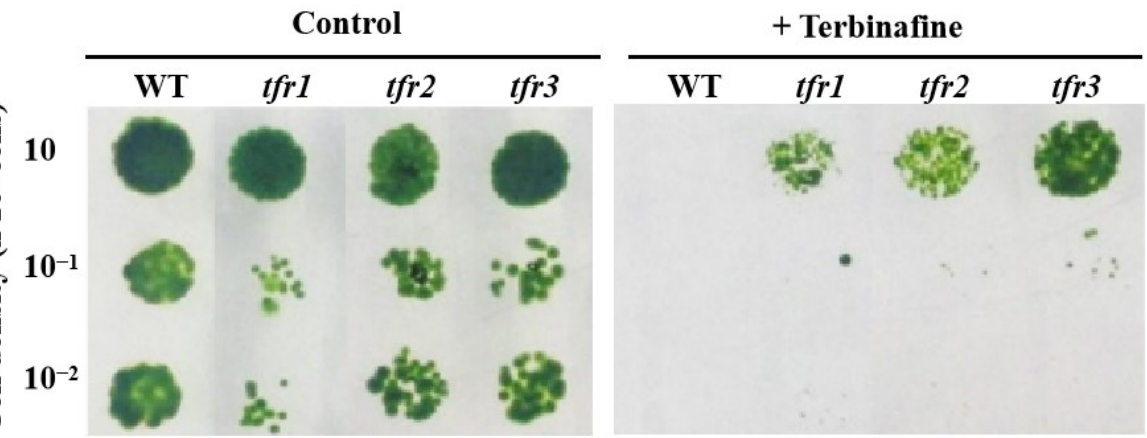
Figure 2. Growth phenotype of wild type (WT) and tfr mutants of C. reinhardtii . Serial dilutions of cells were spotted onto the agar medium without terbinafine ( left ) and with 1 mM terbinafine ( right ) and cultivated for 1 week.